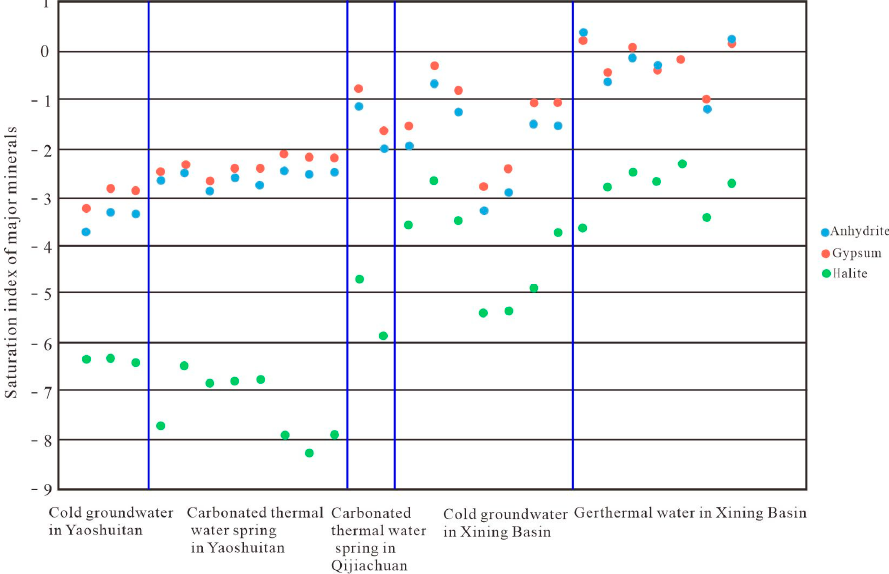
Figure 3. Saturation index distribution of main soluble minerals in carbonated thermal water spring, geothermal water, and cold groundwater in Xining Basin.